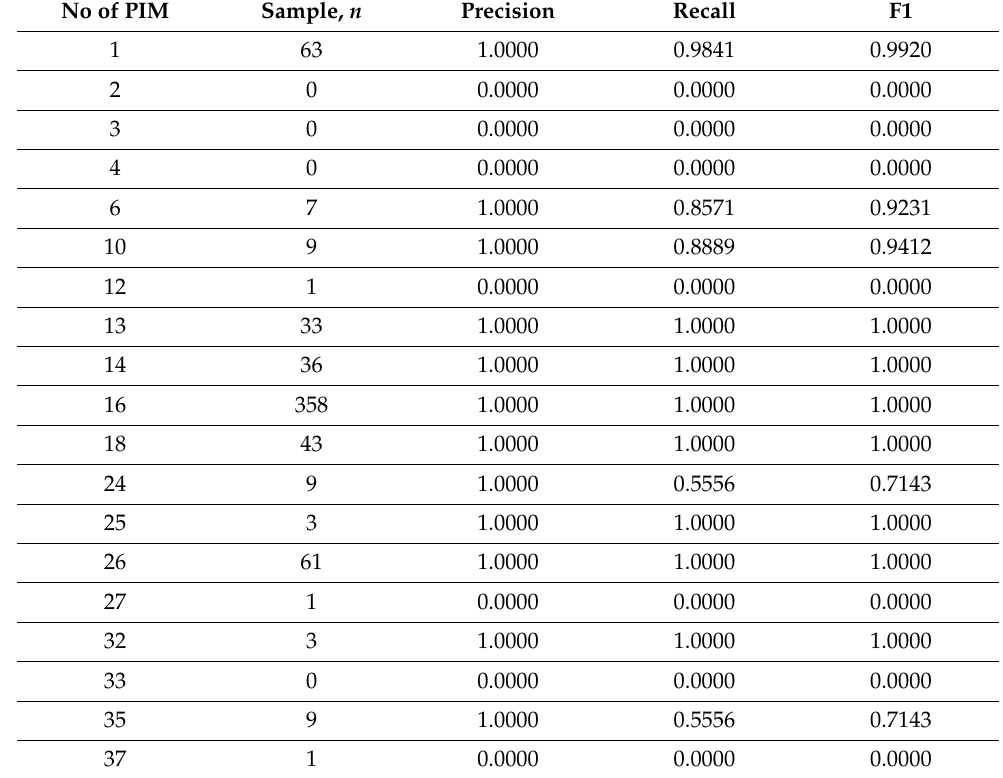
Table 3. The performance of each PIM by the CC + CatBoost model in the test set. PIM: Potentially Inappropriate